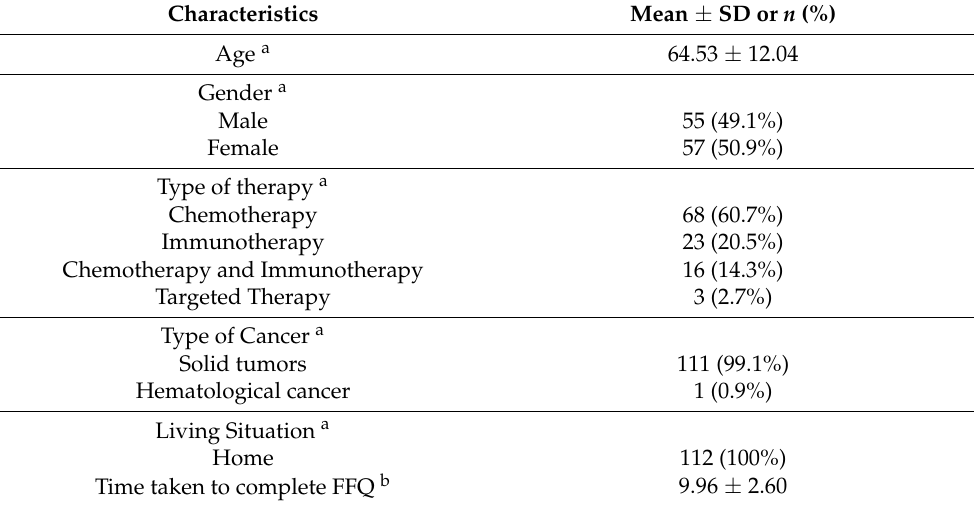
Table 1. Characteristics of oncology participants included in the study exploring the validity of short FFQ against the reference standard diet